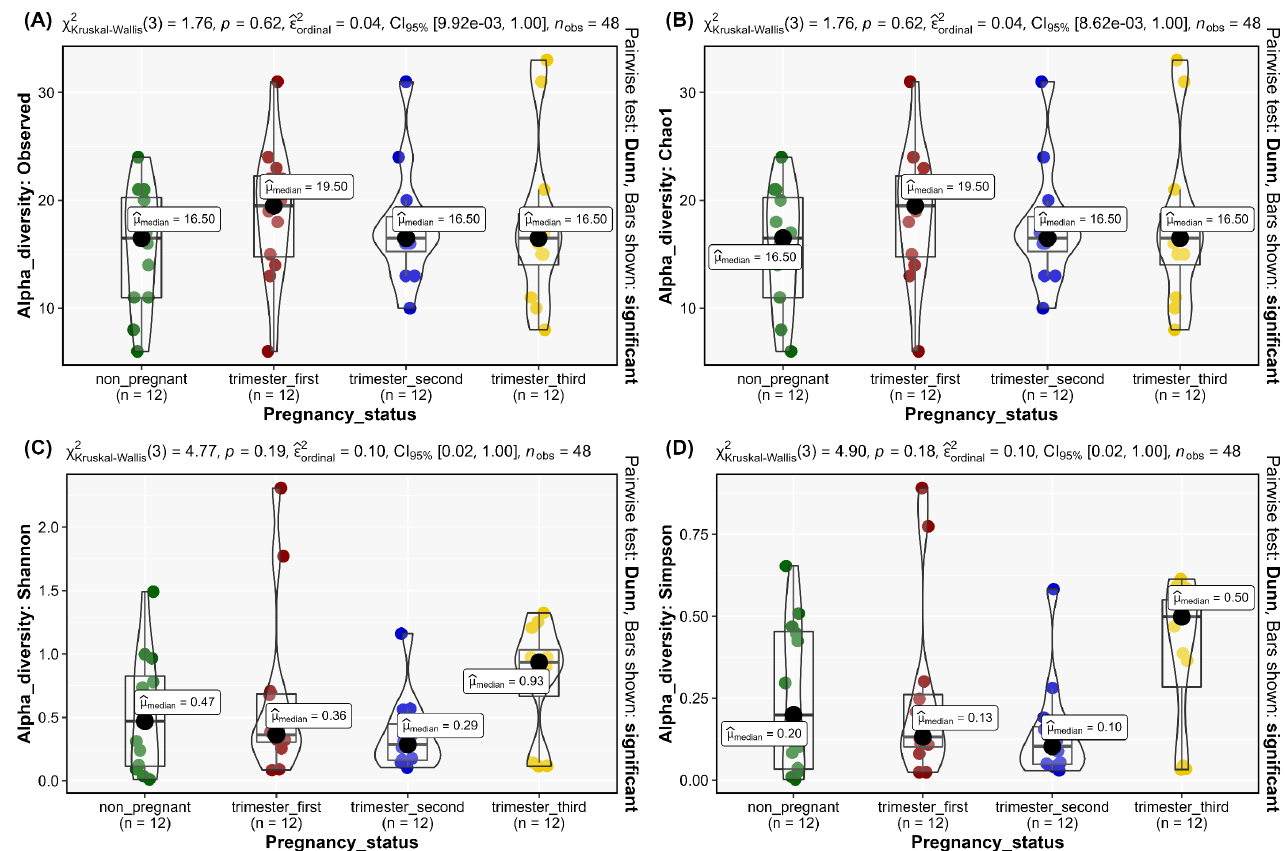
Figure 3. Alpha diversity indices of vaginal microbial communities across the three trimesters of